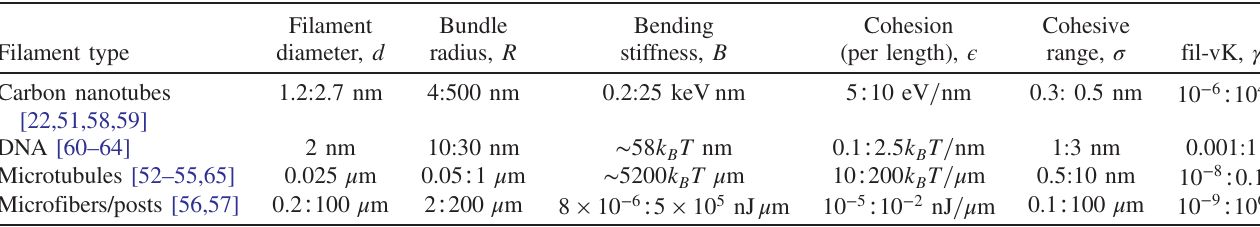
TABLE I. Estimated values of fil-vK for cohesive filament bundles of different materials. Microtubule bundle parameters have been estimated considering interactions that range from relatively weak and long-range depletion [52,53] to shorter-range and stronger binding due to polyvalent counterion binding [54,55]. Here, cohesion between polymer microfiber arrays is modeled by capillary bridging